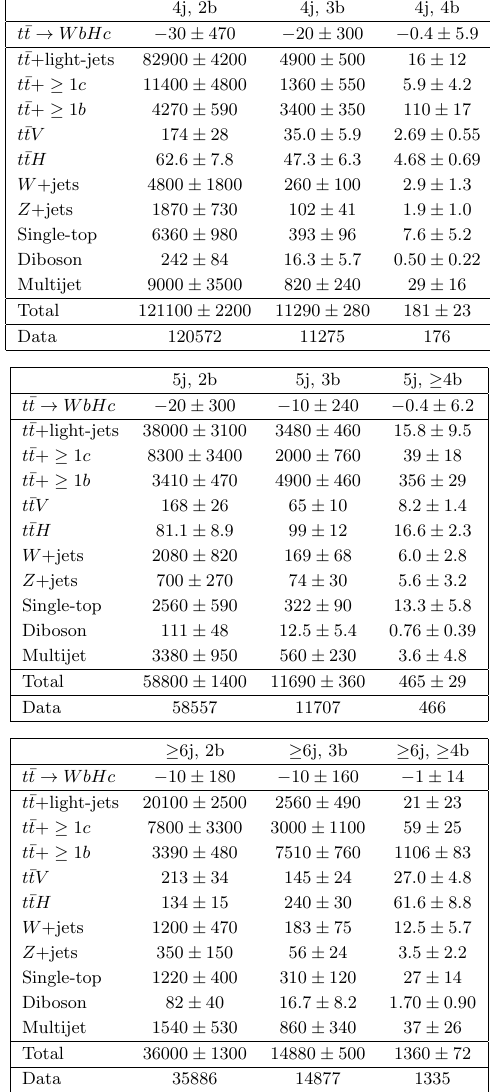
Table 5 . tqH ( b (cid:22) b ) search: predicted and observed yields in each of the analysis regions consid- ered. The background prediction is shown after the (cid:12)t to data under the signal-plus-background hypothesis (assuming t (cid:22) t ! WbHc as signal). The quoted uncertainties are the sum in quadrature of statistical and systematic uncertainties of the yields, computed taking into account correlations among nuisance parameters and among processes.